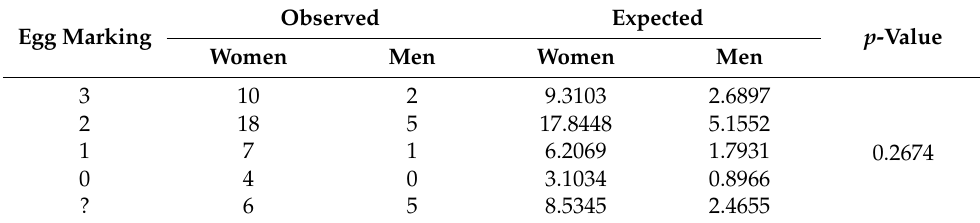
Figure 4. The amount of animal product consumed at once [%]. Table 2. The egg marking choices according to the sex of the respondents.